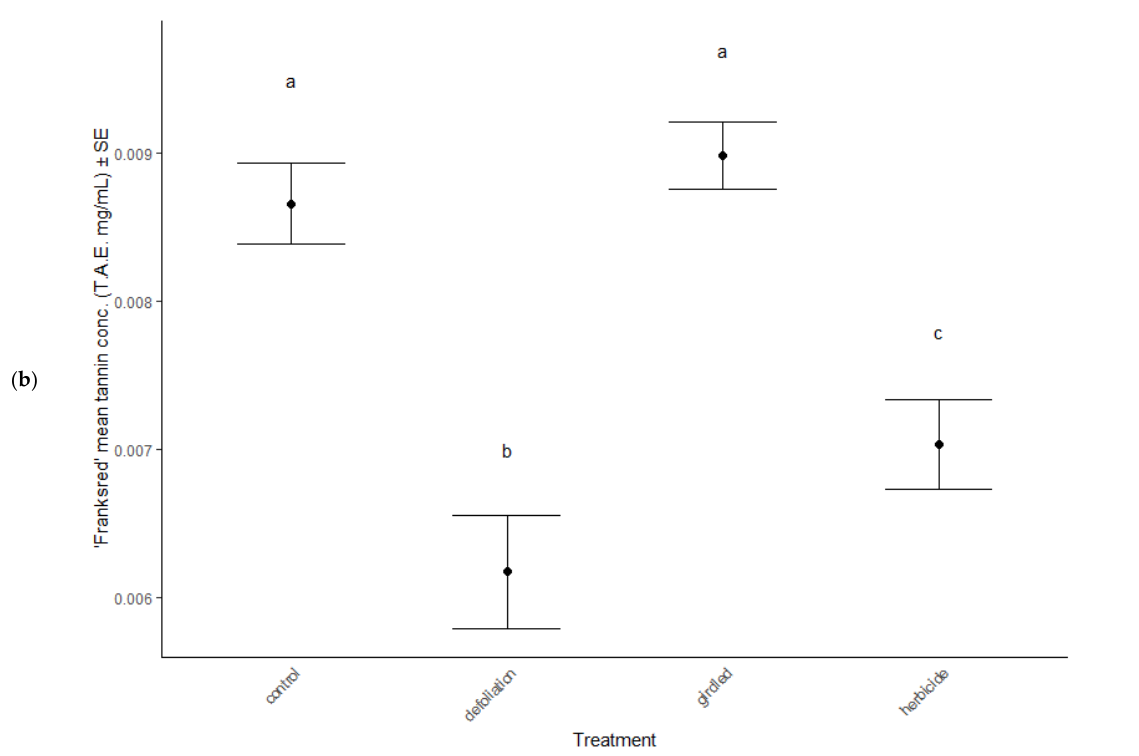
Figure 5. Total tannin concentrations in foliage of stress treatments in June, after reflush of defoliated and herbicided treatments. ( a ) ‘Brandywine’ and ( b ) ‘Franksred’ cultivars of red maples ( Acer rubrum ). T.A.E. = tannic acid equivalents (see methods section for details). Different letters represent statistical differences between treatments according to a post hoc Tukey HSD analysis. In June, total non ‐ structural carbohydrate concentrations were elevated in defoliated and herbicided treatments compared to controls of both cultivars ( post hoc TukeyHSD: all p < 0.001, Figure 6a,b), but all treatments had similar concentrations of TNC by the end of the season, in September (ANOVA: F = 0.85, p = 0.471, Table 2).